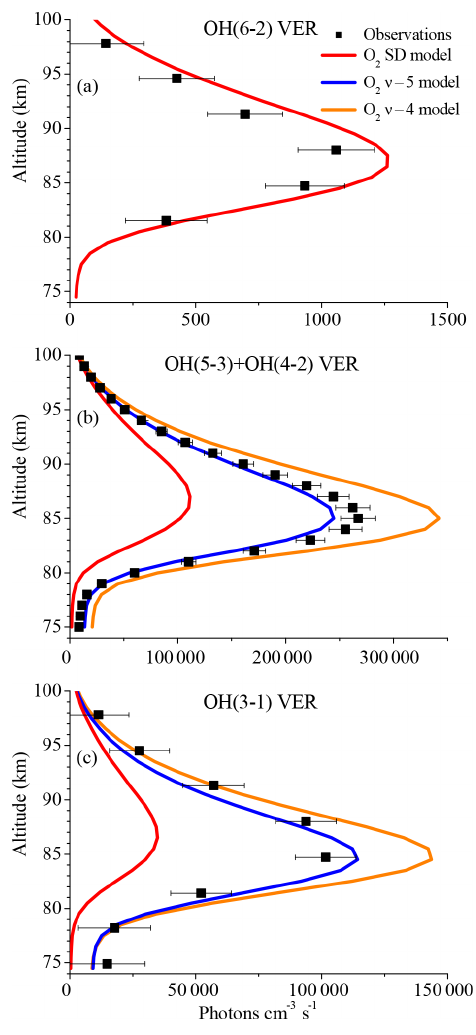
Figure 3. Same as Fig. 1 but for the O 2 SD model, the O 2 ν − 5 model, and the O 2 ν − 4 model. Note that the results of these three models are identical in the case of the OH(6-2)